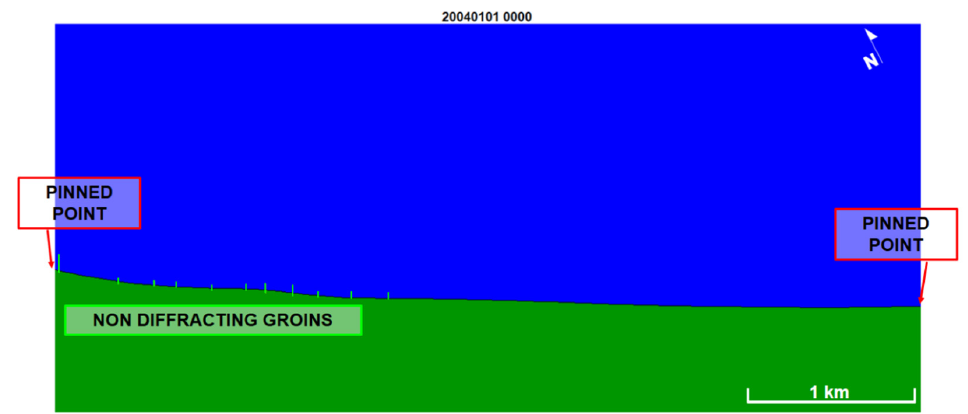
Figure 11. GENESIS configuration of the modeled area. All structures defending the area since 2004 were reproduced with the same length and mutual distance.